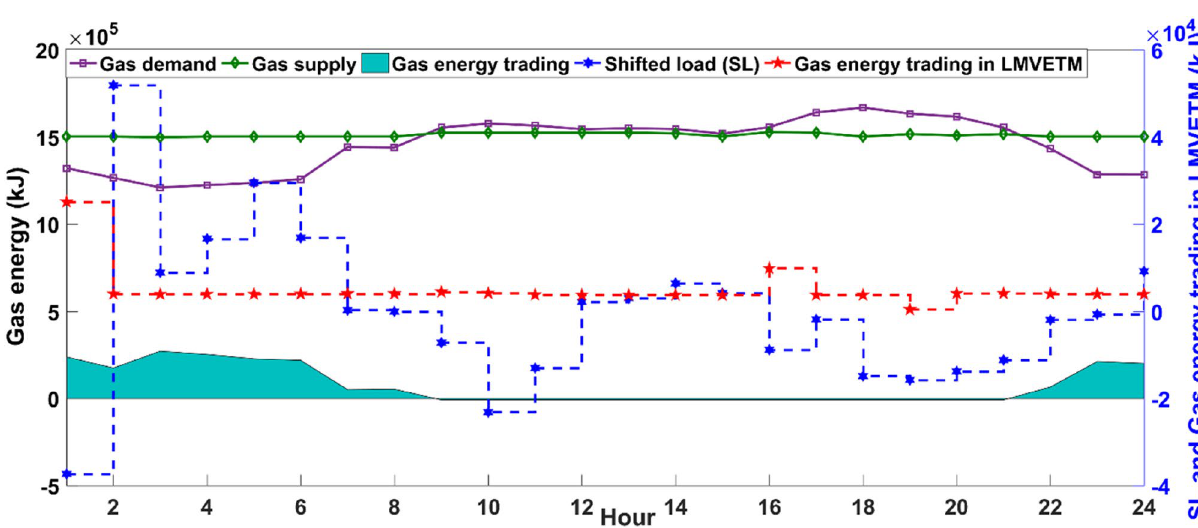
Figure 7. Optimal scheduling of the NGG systems. It specifies how NGG units interact with other parts of the incorporated energy system for maintaining the stability of the